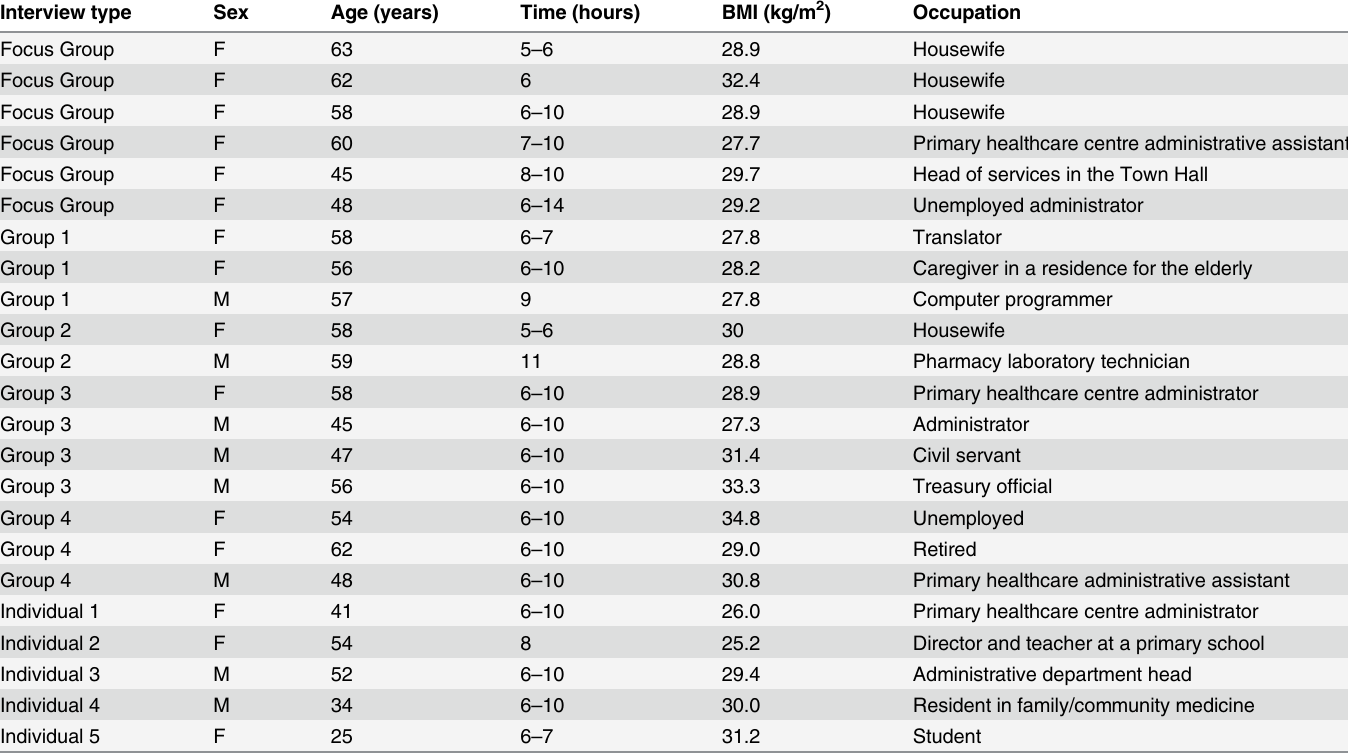
Table 1. Summary of participant